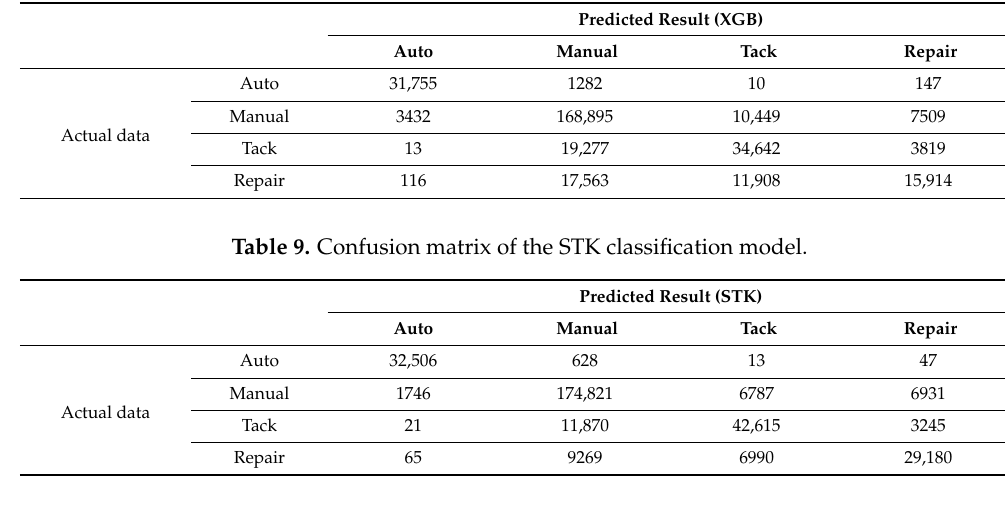
Table 8. Confusion matrix of the XGB classification model.